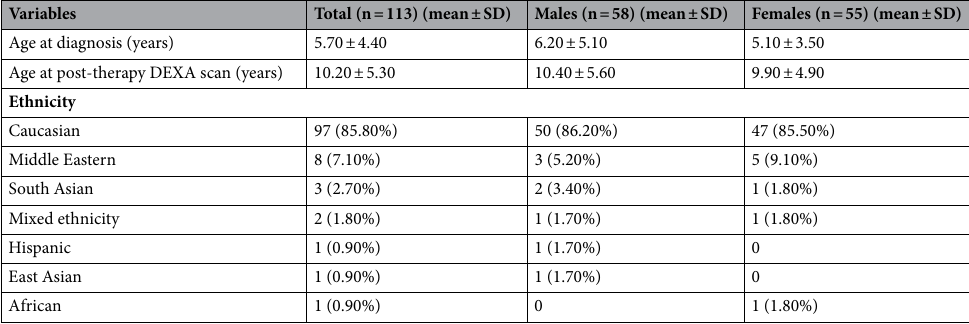
Table 1. Study population characteristics. SD standard